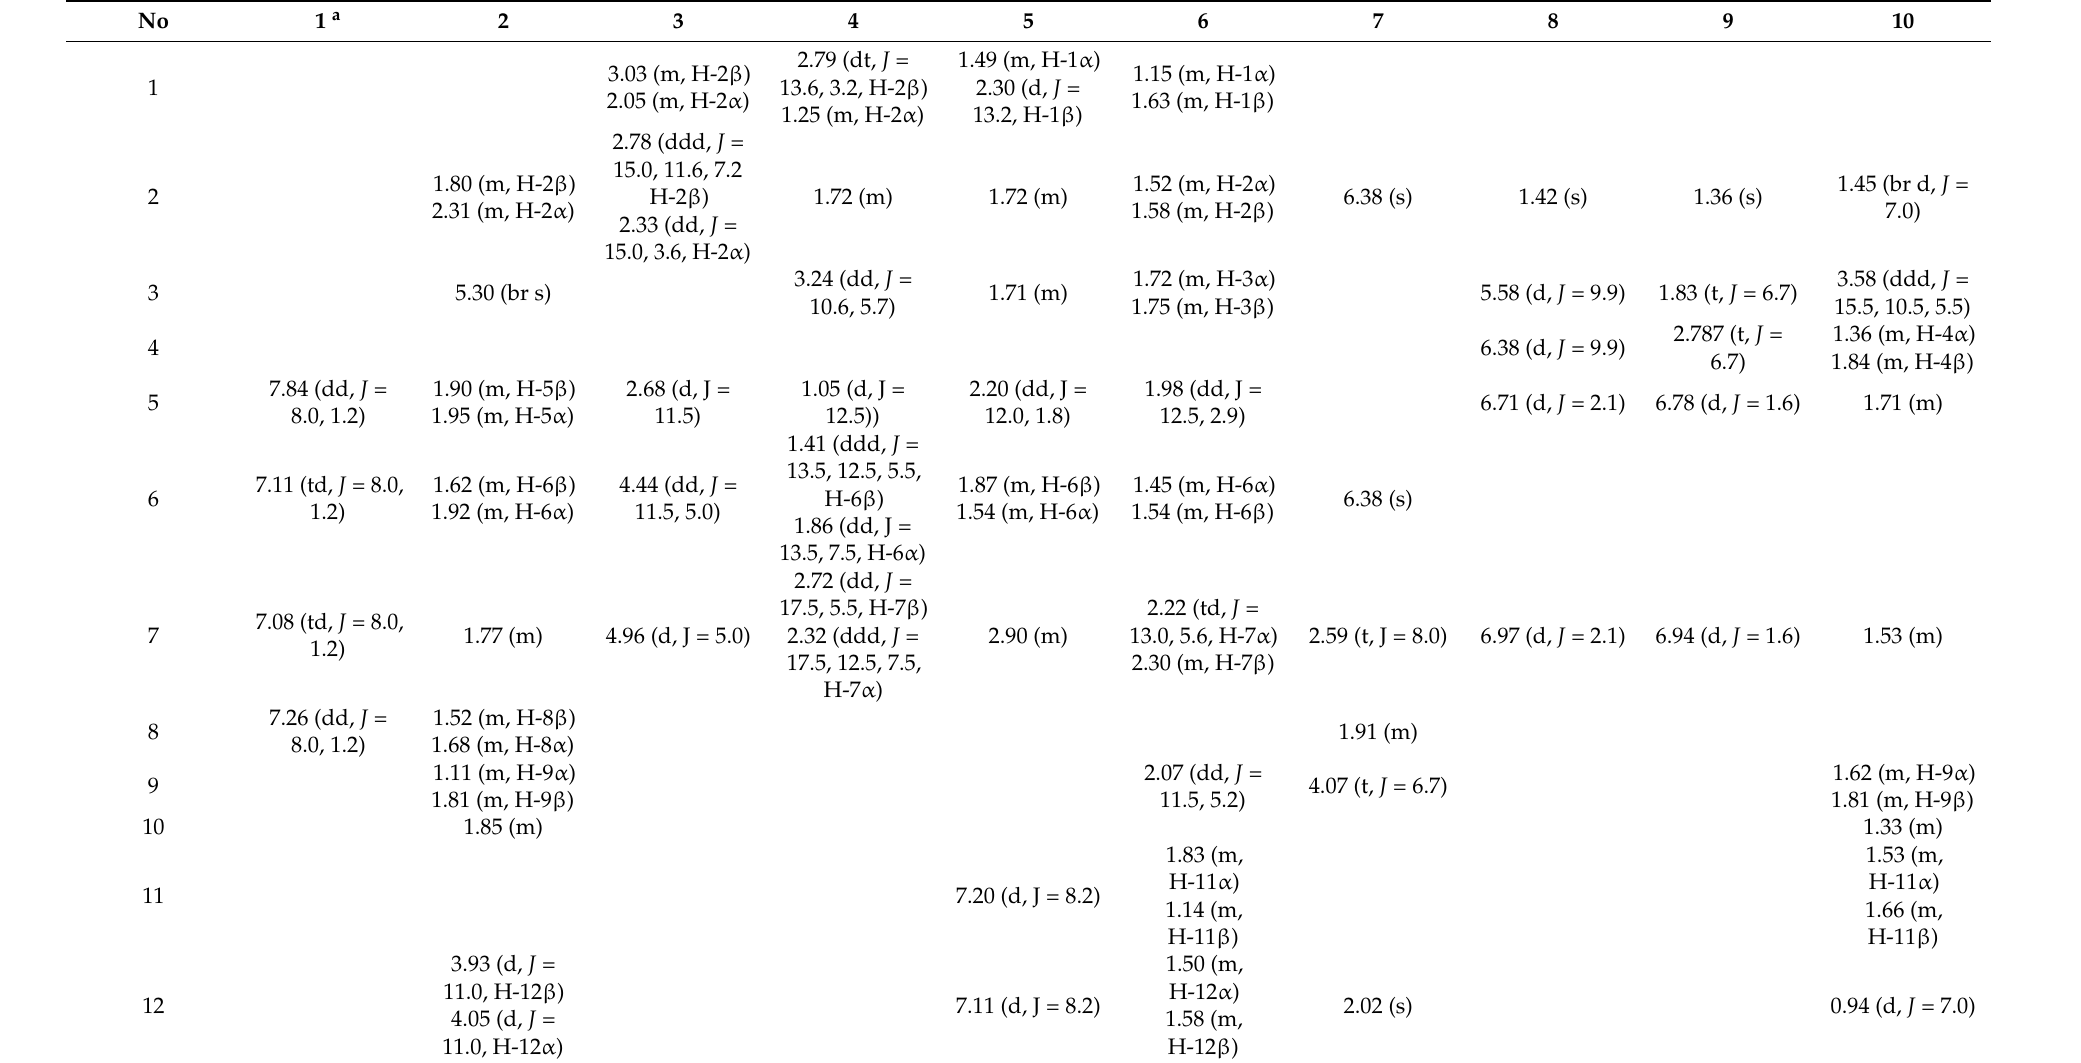
Table 1. 1 H NMR Data for Compounds 1 – 10 in CDCl 3 ( δ in ppm, J in Hz, 500 MHz in CDCl 3